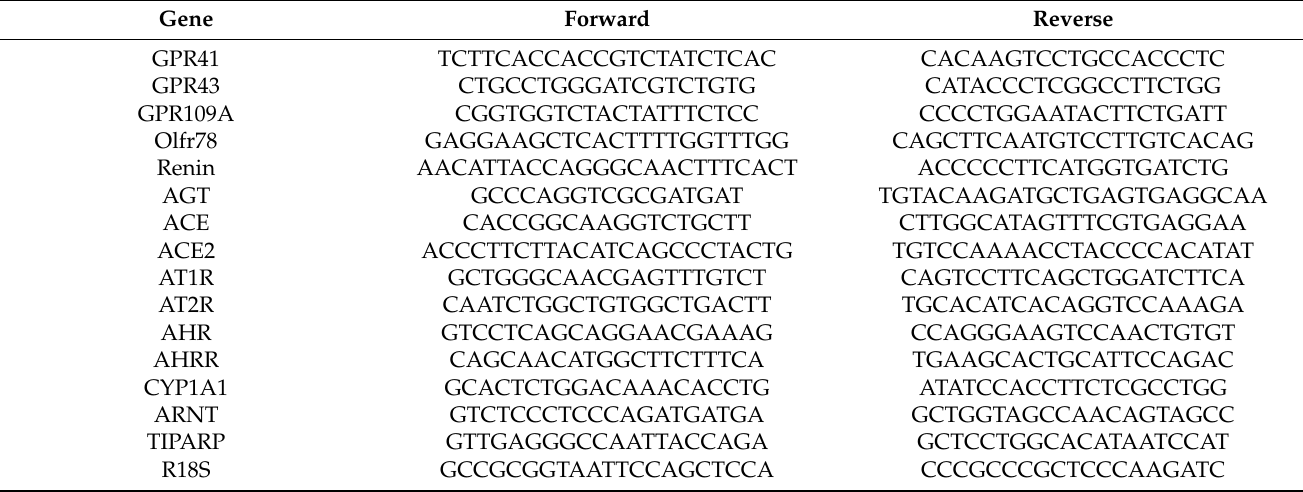
Table 1. List of primer sequences used for qPCR